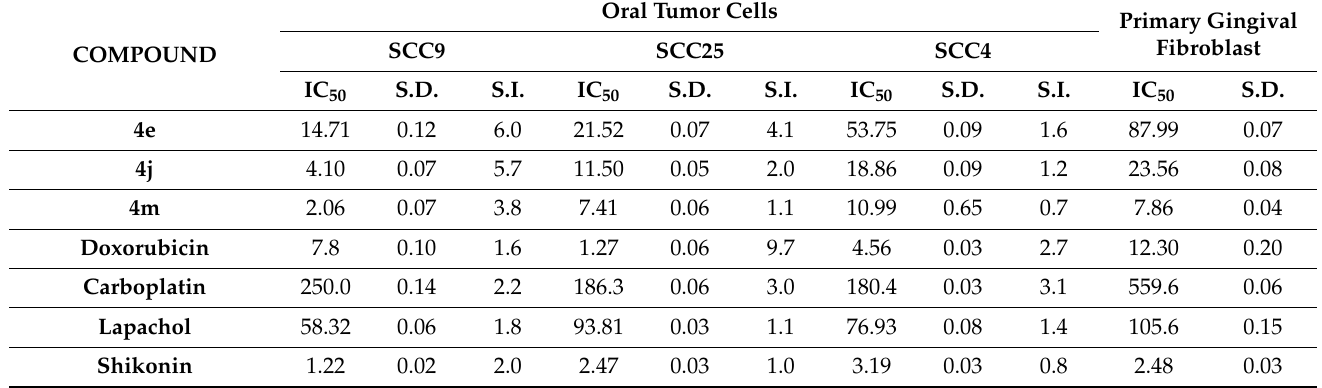
analysis is needed to determine if the compound is chemically stable.